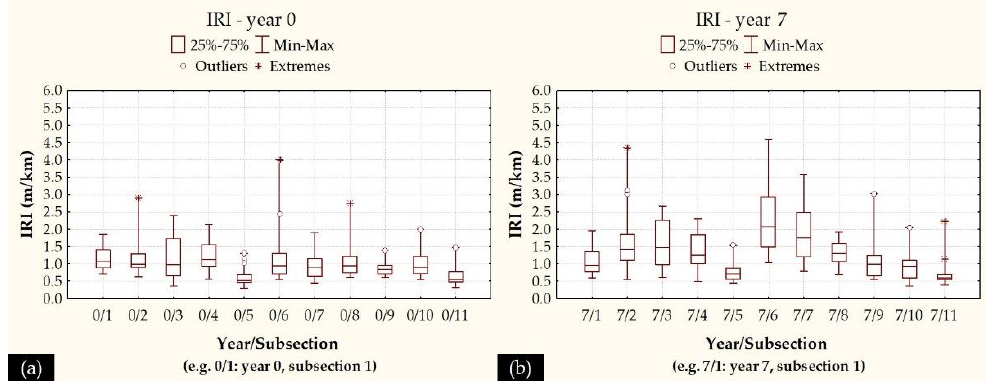
Figure 7. Boxplots of IRI values at the right wheel path (RWP) for ( a ) year 0, and ( b ) year 7.